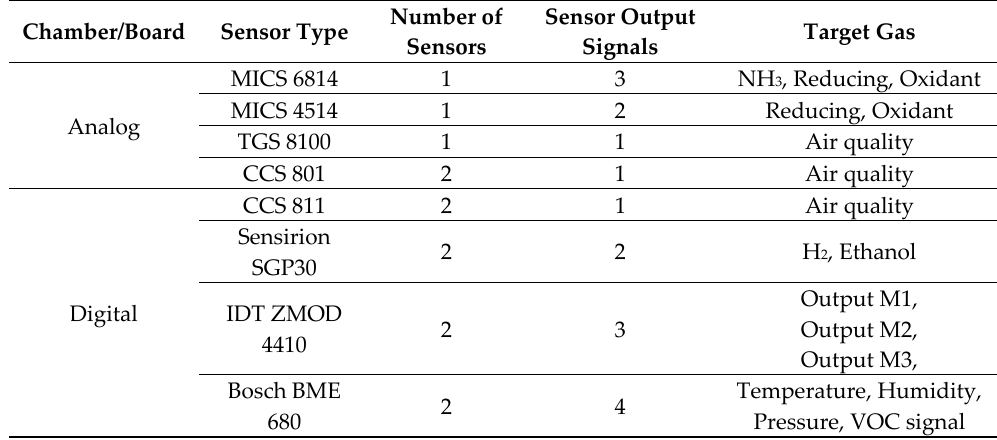
Table 1. Total signals collected per second from a single device using one analog board and one digital board.